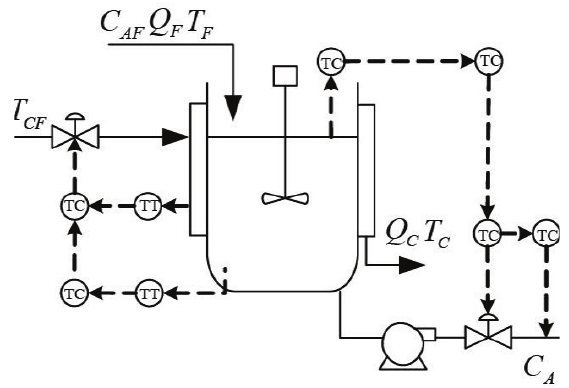
Figure 11. Diagram of the CSTR